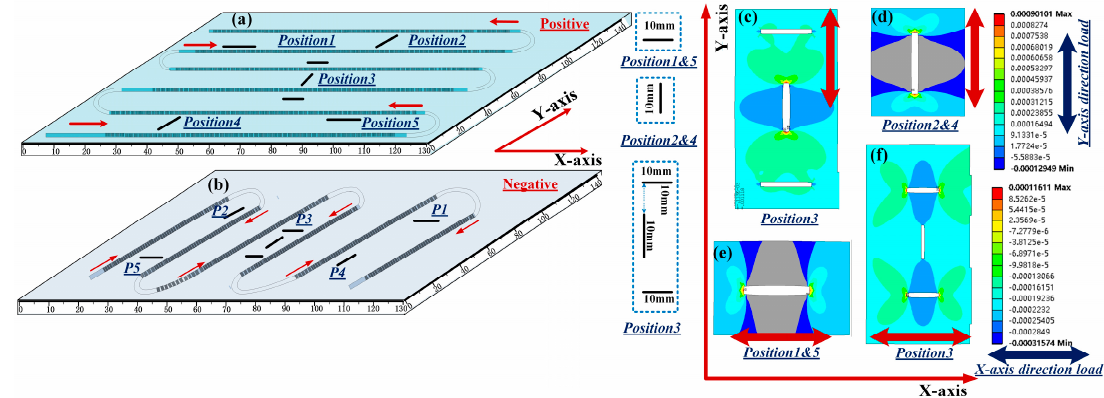
Figure 8. Sensor placement on ( a ) the front side and ( b ) the back side of Specimen2. Simulated strain distributed at ( c ) Position 3 and ( d ) Position 2 & 4 when the external force is applied along the Y -axis direction with 5 kN load. Simulated strain distributed at ( e ) Position 1 & 5 and ( f ) Position 3 when the external force is applied along the X -axis direction with 5 kN load.